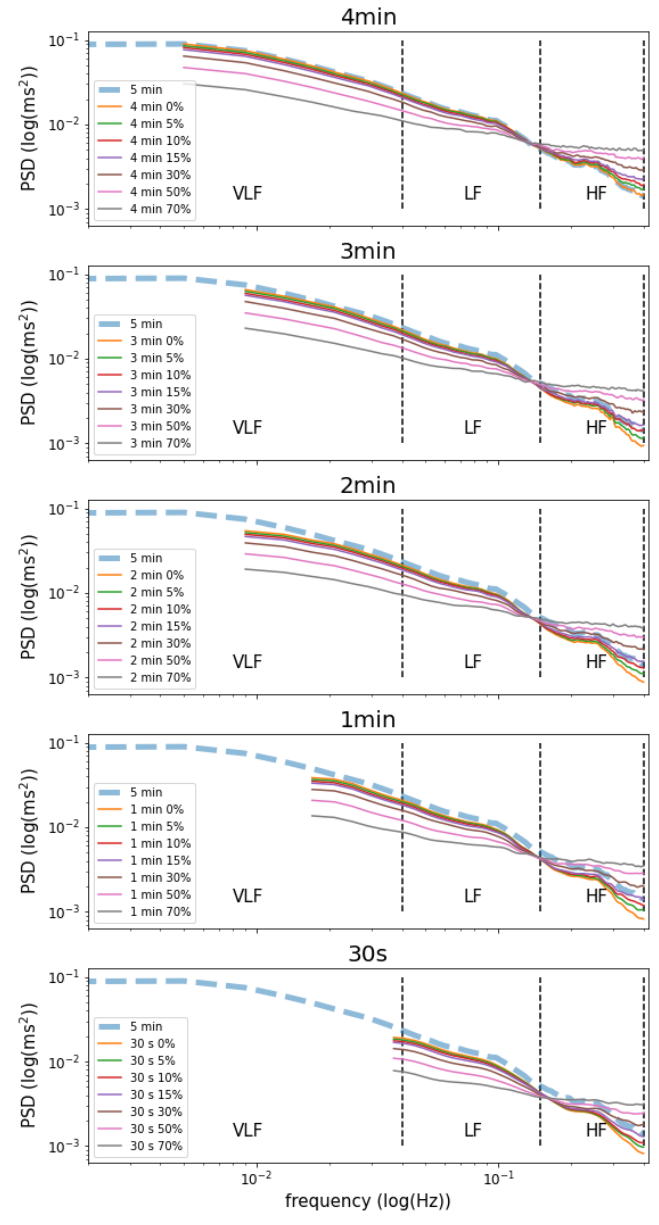
Figure 1. Power Spectrum Density plot for timeseries with different time series length and missing values percentage. The blue dotted line in each plot reflects the power spectrum of the 5 min time